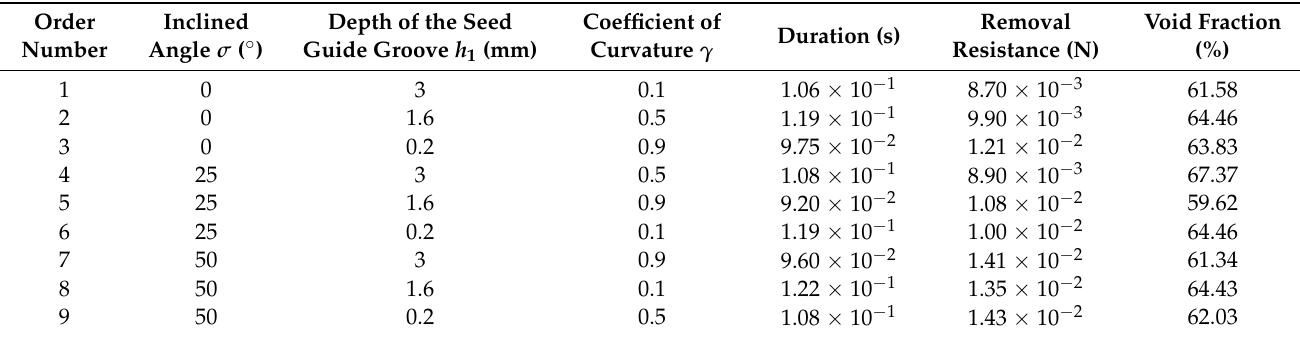
Table 5. Simulation results of the maize seed